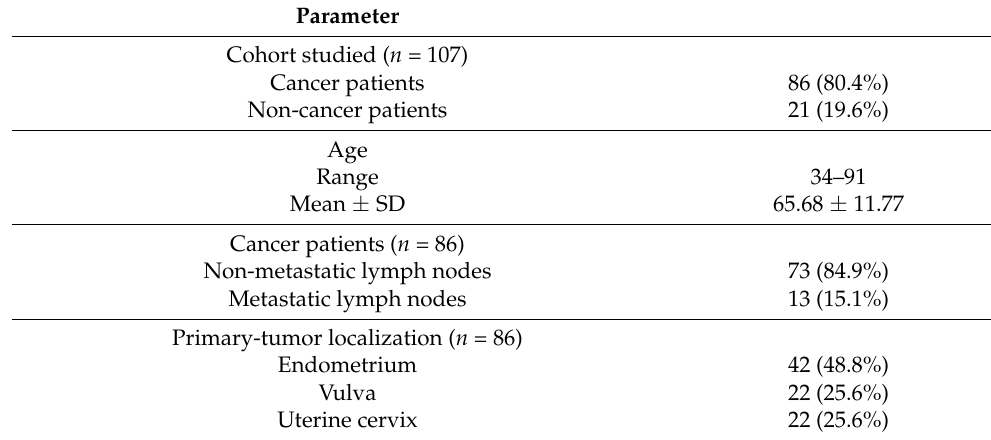
Table 1. Cohort’s